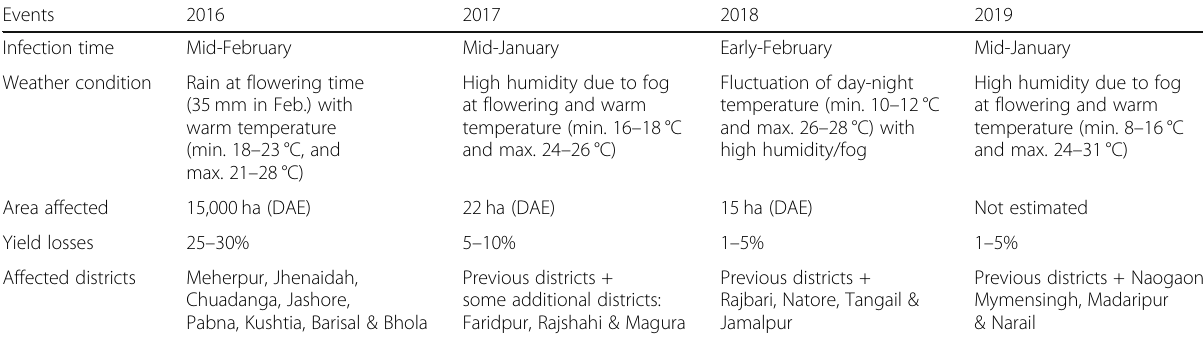
Table 2 Comparative status of blast incidence during 2016 – 2019 in Bangladesh (Data source: